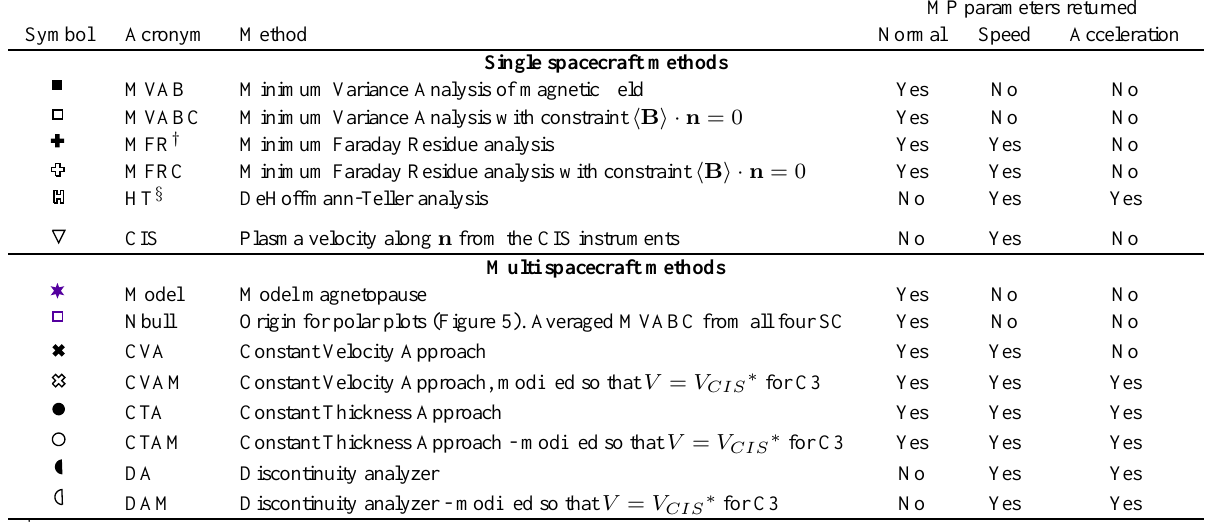
Table 1. Overview of methods, and their acronyms, and symbols. 4 Haaland et al.: Four Spaccraft Determination of Magnetopause Orientation and Motion